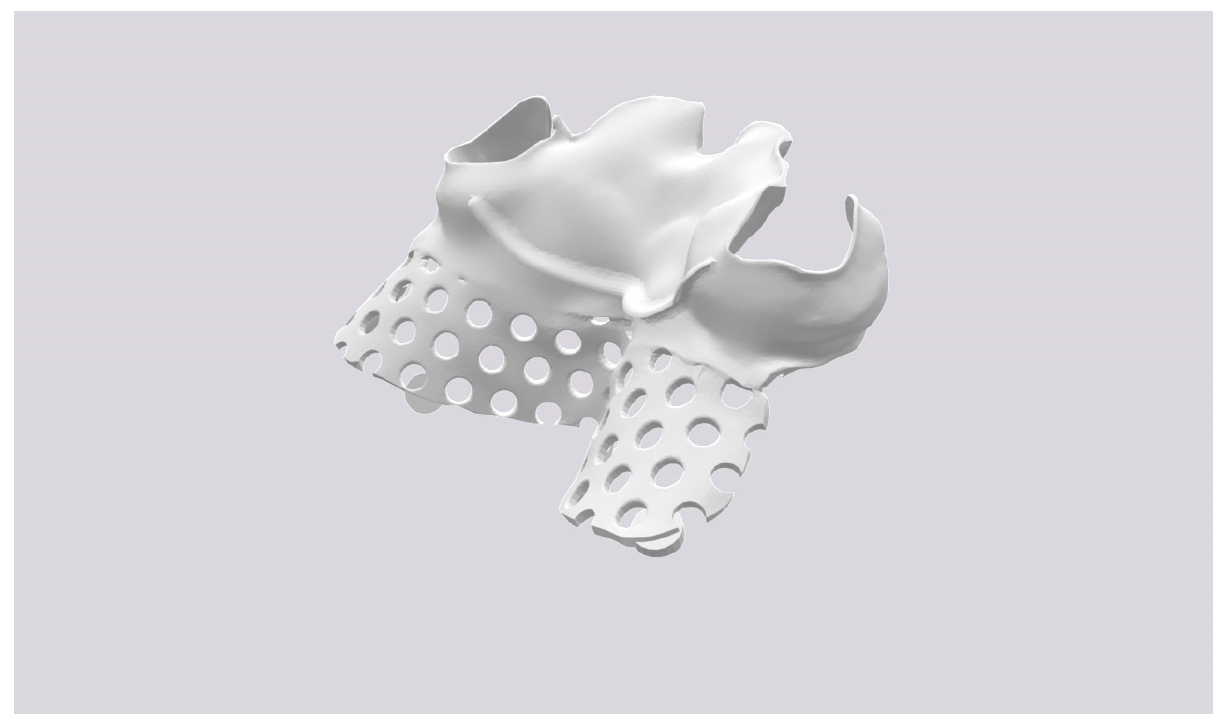
Figure 8. The unconventional size and shape of clasps required to provide adequate retention when fabricating frameworks from thermoplastic polymers.